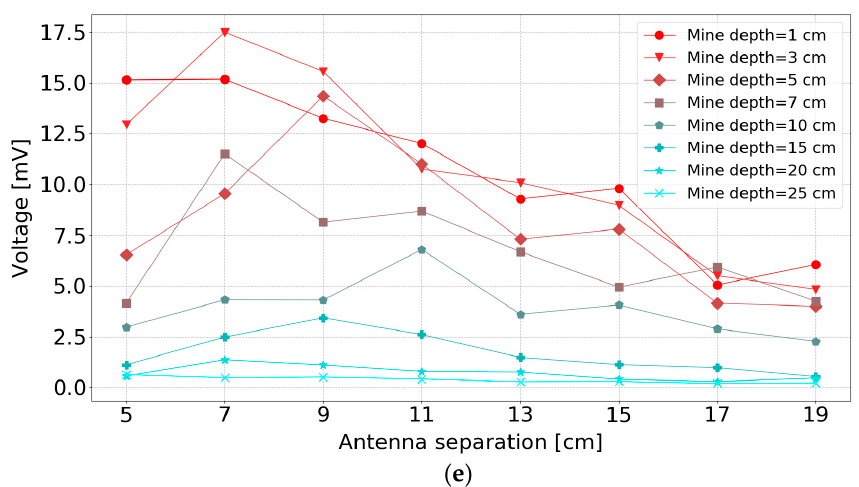
Figure 10. Results of antenna separation at a 3 cm lift-off height: ( a ) Lossless soil with a relative permittivity of 20 (simulation); ( b ) Lossy soil with a relative permittivity of 20 (simulation); ( c ) Lossless soil with a relative permittivity of 8 (simulation); ( d ) Lossy soil with a relative permittivity of 8 (simulation); ( e ) Loamy soil (measurement).